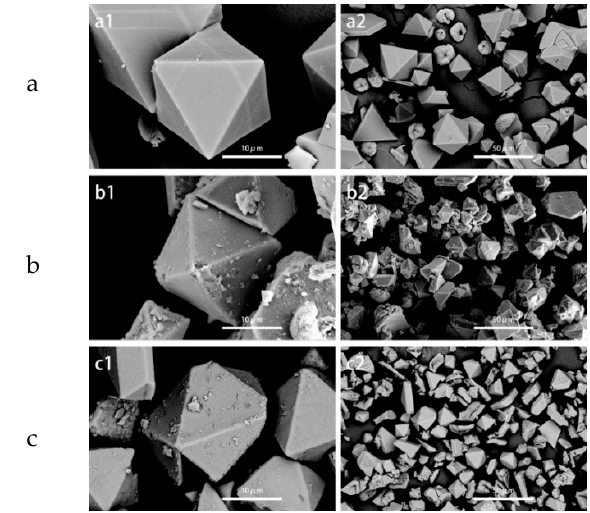
Figure 3. The scanning electron microscopy (SEM) images of HKUST-1 ( a 1 , a 2 ), TEBAC-HKUST-1 ( b 1 , b 2 ), and the recovered TEBAC-HKUST-1 ( c 1 , c 2 ).